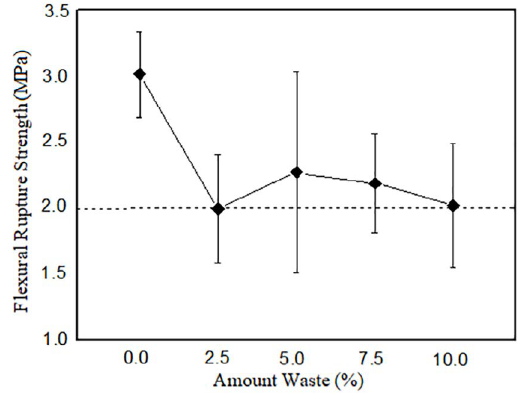
Figure 8. Flexural strength of the different ceramic compositions.